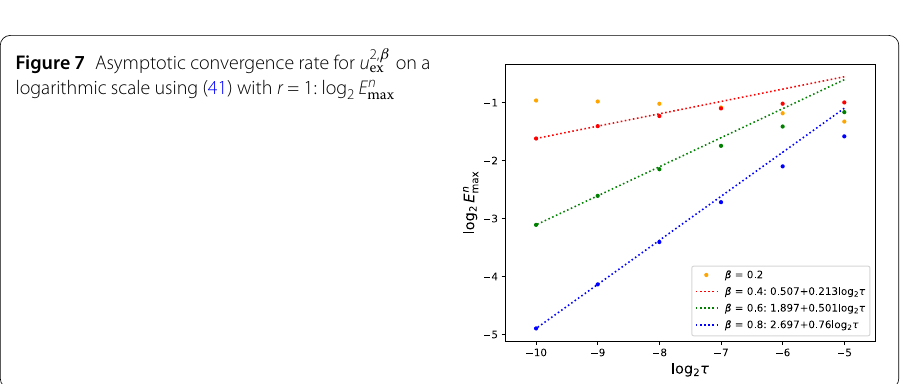
Figure 7 Asymptotic convergence rate for u 2, β ex on a logarithmic scale using (41) with r = 1: log 2 E n